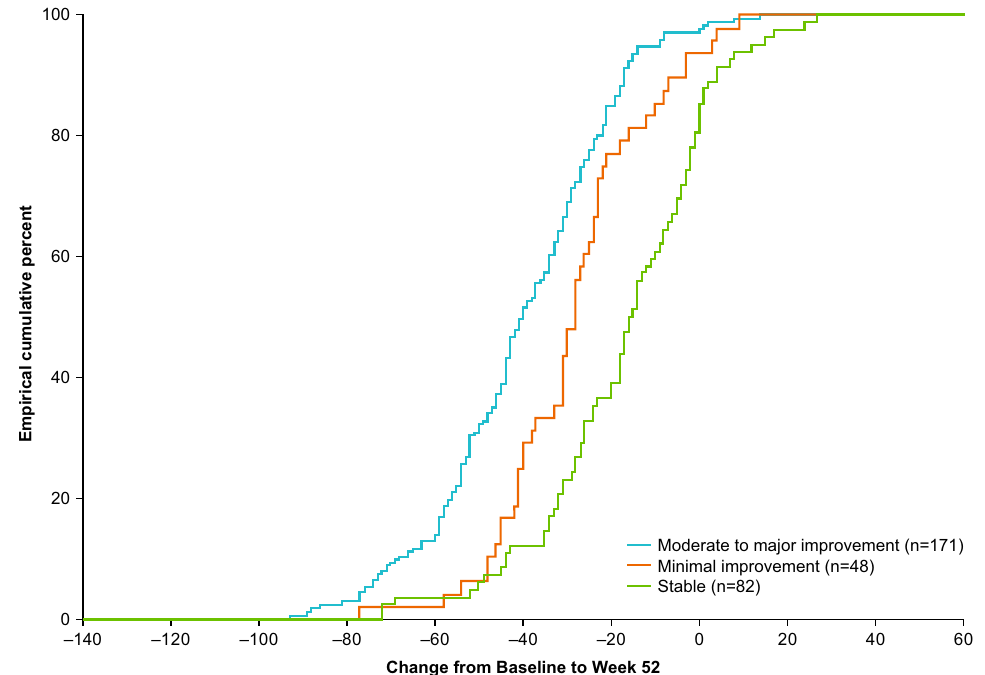
Fig. 2 Mean change in SNOT-22 score by VAS anchor in total ITT population. Overall VAS anchor groups were defined by change in overall VAS symptom score from baseline to Week 52: moderate to major improvement: improvement: 2 to > 4-point change in VAS score; limited improvement or worsening (stable): > ≤ − − Cumulative distribution function, CI Confidence interval, ITT Intent-to-treat, SNOT-22 Sino-nasal outcome test-22, VAS Visual analogue scale